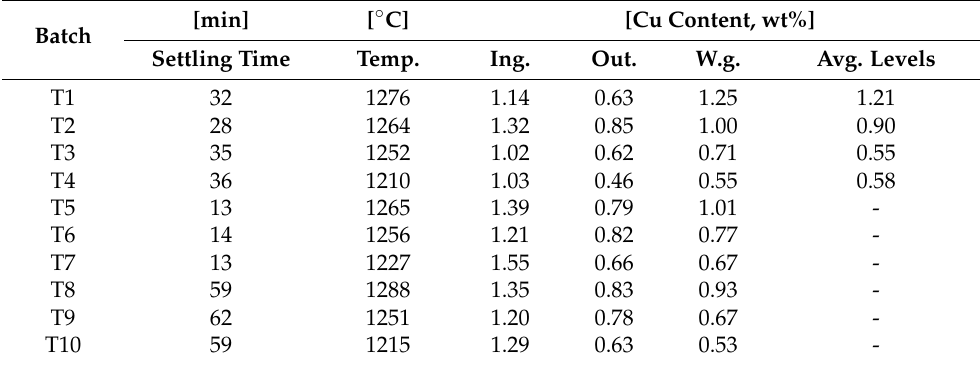
Table 3. The settling time, temperature, and average copper contents in ingoing (ing.), outgoing (out.), and vertical (avg. levels) slag samples, and the copper content in the water-granulated slag (w.g.). The complete compositions for the samples are found in Table A1.